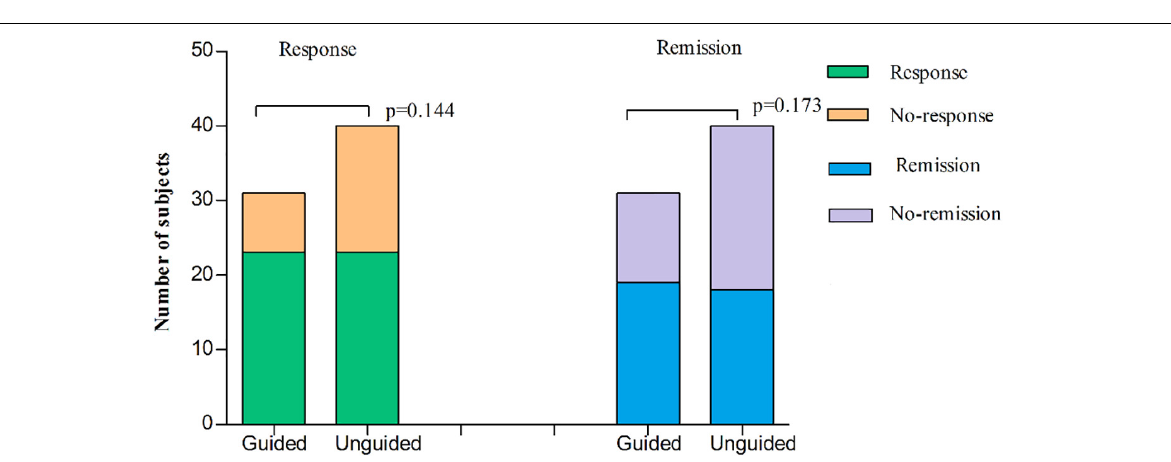
FIGURE 4 | The subjects of response or remission at 8 weeks treatment in the guided group and the unguided group. Response to therapy was defined as the RR of HAMD-17 by ≥ 50%. Remission was defined as the final HAMD-17 score ≤ 7 at the end of the 8-week treatment. The two histogram bars on the left represent the treatment response of two groups and the two right represent treatment remission of two groups. P -values on the left and right represent the comparison of response rates and remission rates respectively, between two groups. P -values are derived using χ 2 tests. HAMD-17 = 17-item Hamilton depression scale; RR, reduction